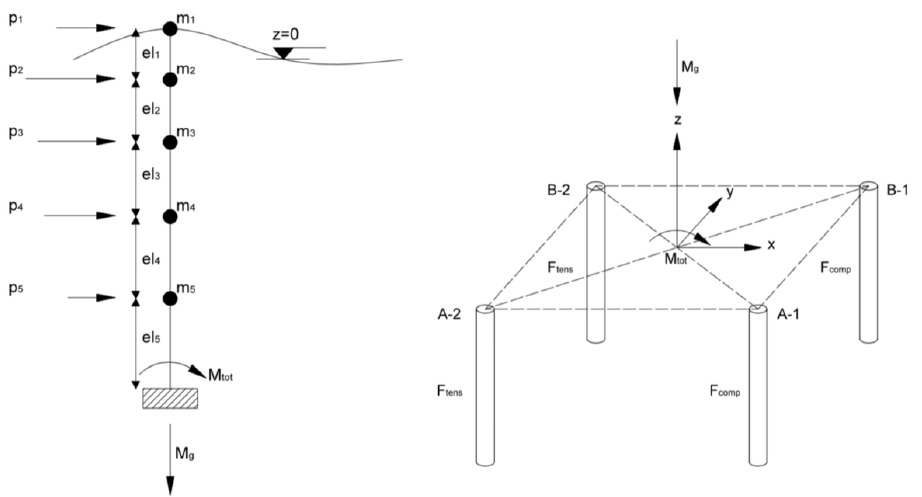
Figure 3. Pile stress analysis of the 5DOF model.